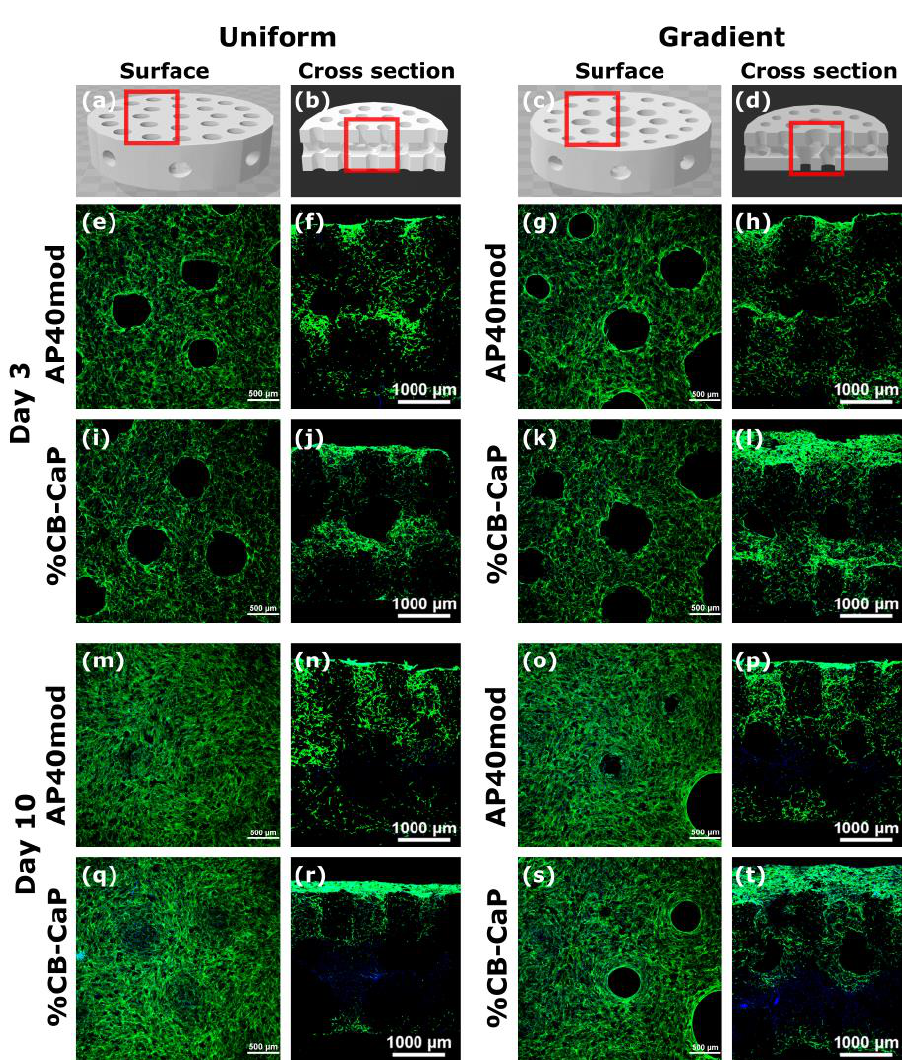
Figure 9. Confocal images of the cells seeded on the scaffolds and cultured for 3 and 10 days. The cytoskeleton is highlighted in green and the cells’ nuclei in blue. AP: AP40mod ( e , f , g , h , m , n , o , p ); CB: 10%CB-CaP ( i , j , k , l , q , r , s , t ). Images of the surface ( a , c ) or of the cross-section ( b , d